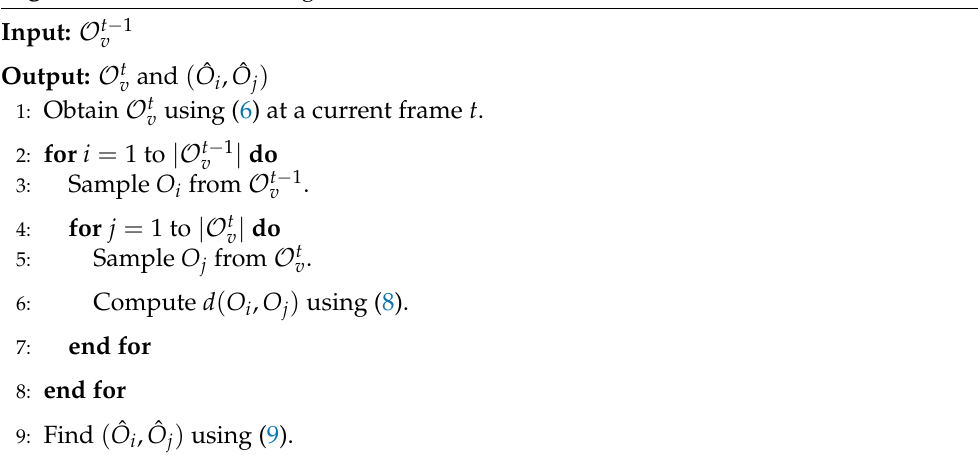
Algorithm 1 Visual Tracking Based on OPV.